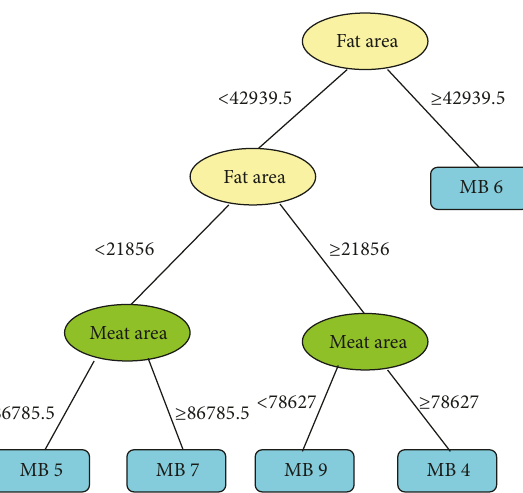
Figure 7: Decision tree for beef image with 4MP